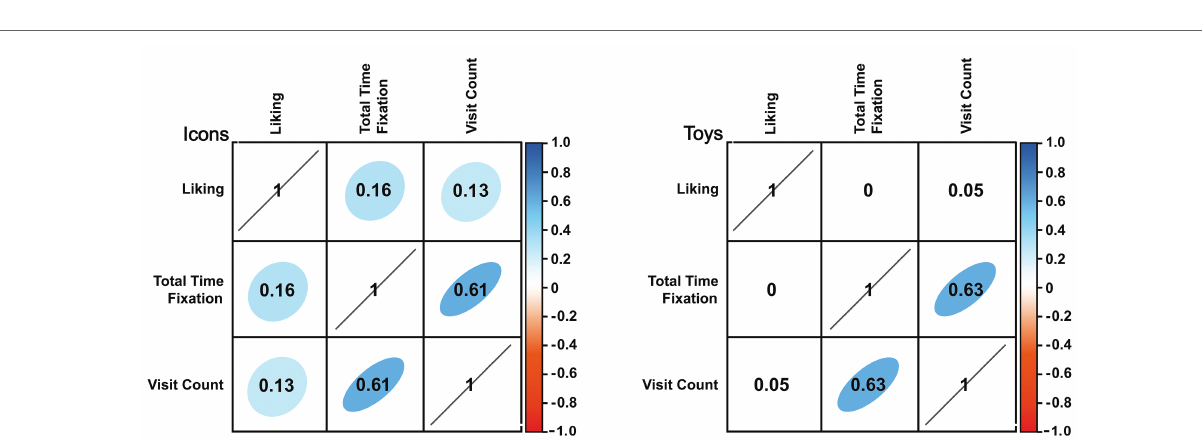
column)] for toys. Gender factor [ F (2.461), p = 0.044] presented differed significantly between boys (mean = 2.023, std = 3.14) and girls (mean = 1.491, std = 1.427). There was no significant interaction between factors.